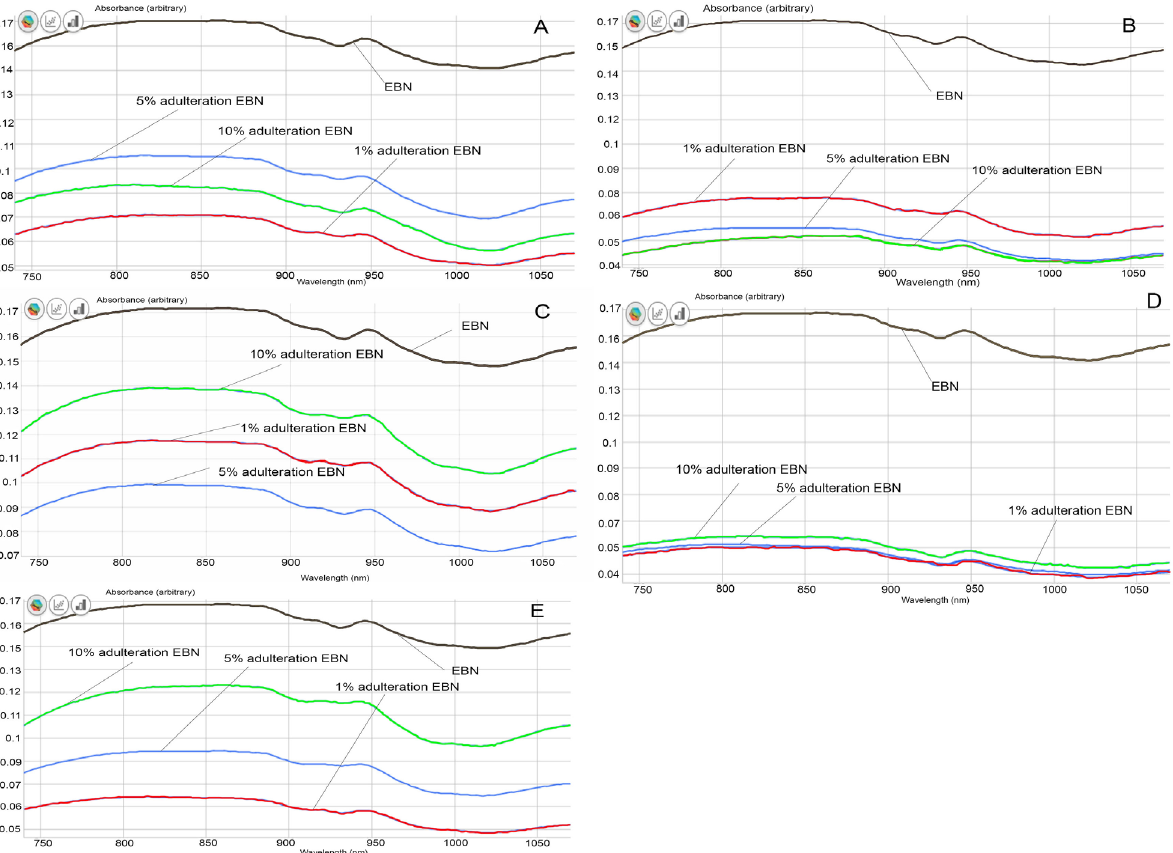
Figure 4. The VIS/SW-NIR spectra of authentic EBNs and adulterated EBNs at concentrations of 1%, 5% and 10% (( A ) melamine, ( B ) karaya gum, ( C ) gelatine, ( D ) collagen, ( E ) nutrient agar). Similar to the VIS/SW-NIR work, the mid-infrared reflectance spectrum of authentic EBN was compared with the spectrum of each type of adulterant, and these are shown in Figure 5, covering the absorption bands ranging from 16,667 to 2500 nm. The bands repre- sent certain functional groups that are present in EBN, and the information is summarised in Table 3. The bands around 7576, 7143 and 6944 nm show the presence of the amine group (C-N), aldehyde group (CH=O) and carboxylic group (COOH), respectively, [46] while the presence of protein is indicated by the absorption bands around 6494 and 6098